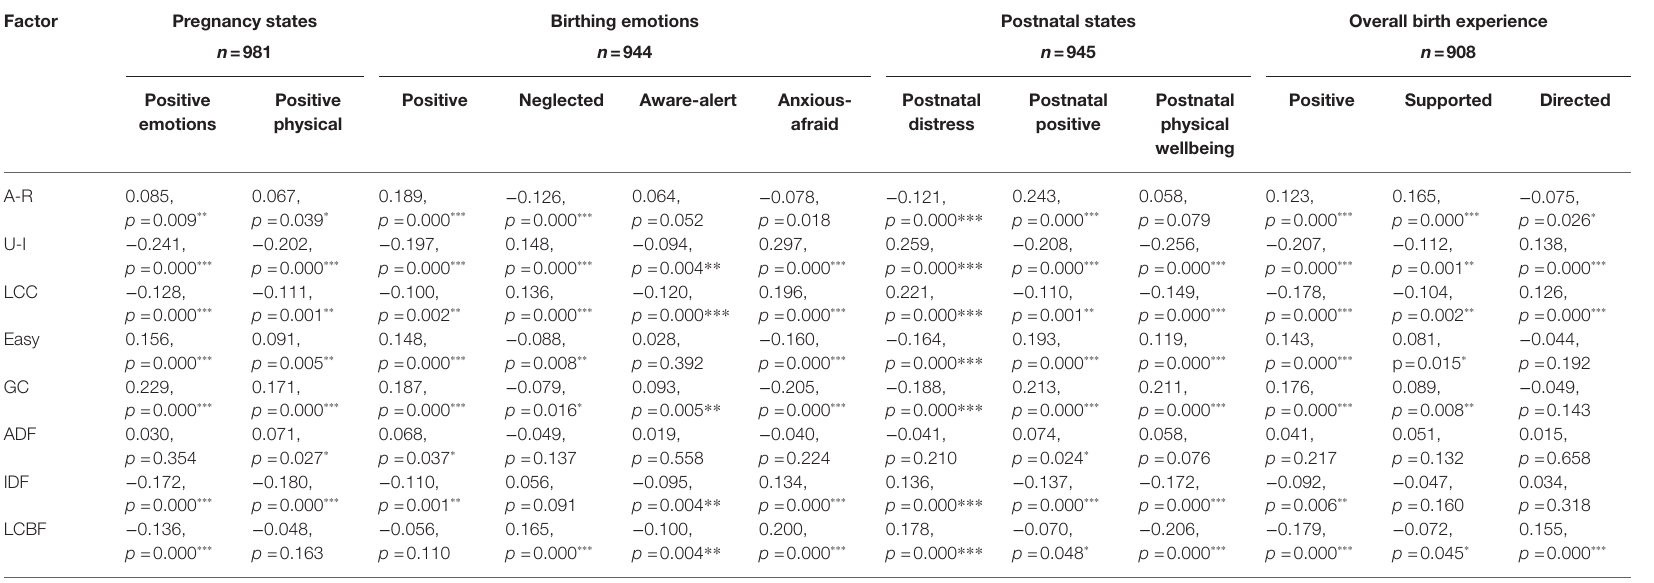
MABS items are defined in Table 1 . * Pearson’s r: p <